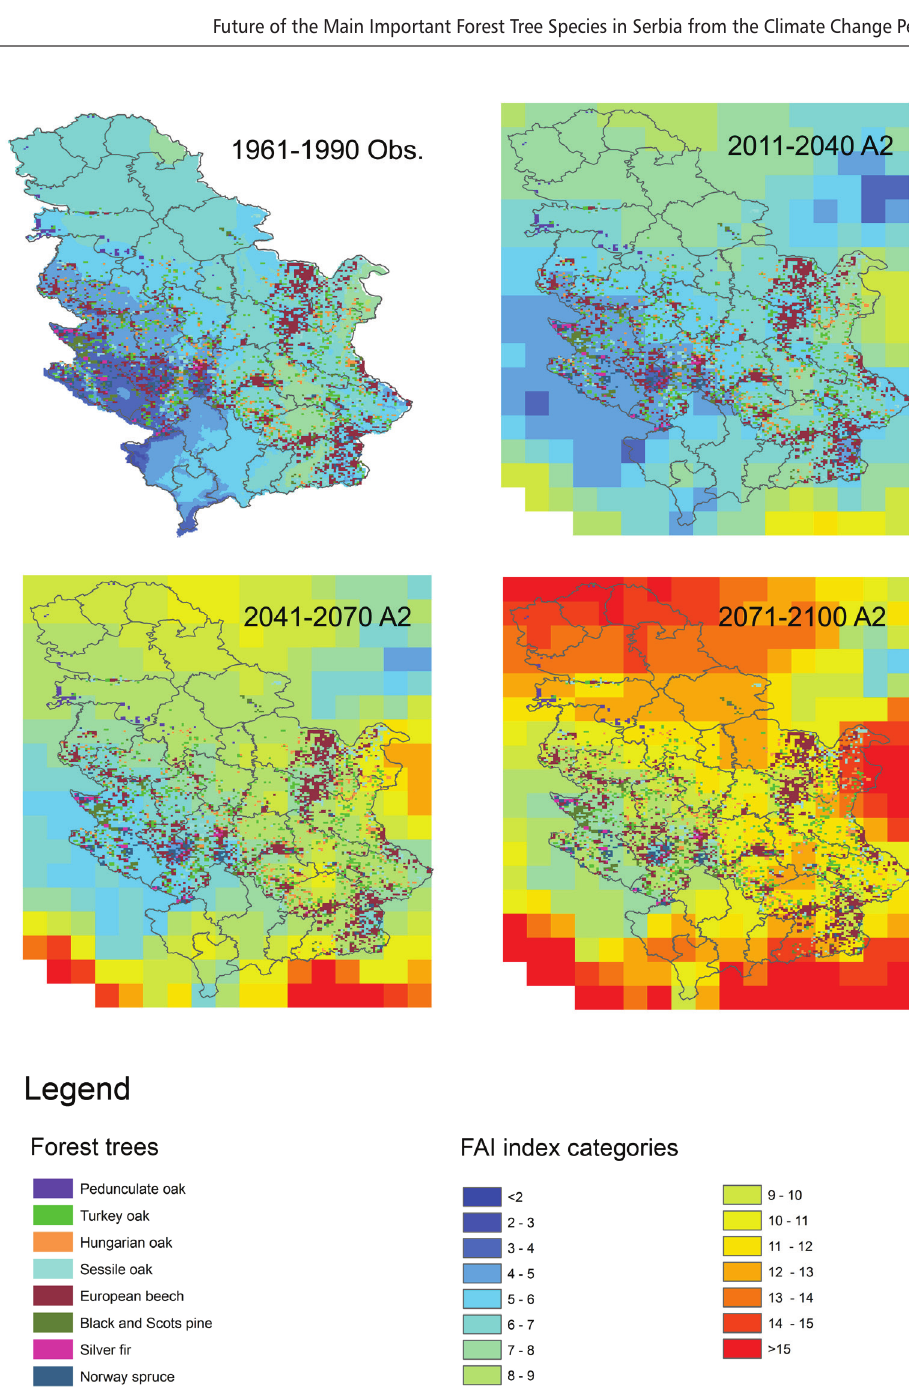
FIGURE 1. Maps of Forest Aridity Index (FAI) for four climatic periods (1961-1990 – observed climate, 2011-2040, 2041-2070 and 2071-2100 - predicted climate according to A2 scenario) and indicated distribution of eight forest tree species in